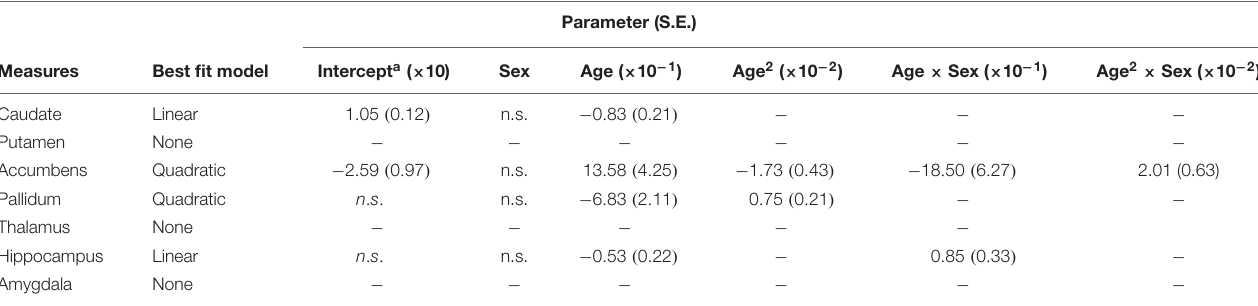
TABLE 3 | Fitting parameters for asymmetries of subcortical structures versus age.